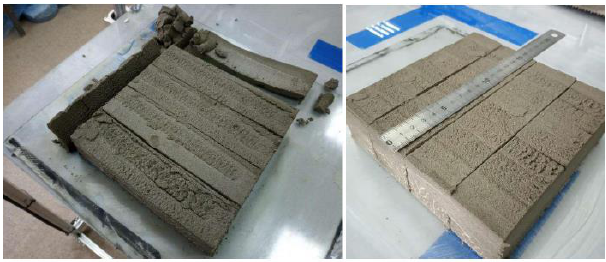
Figure 5. Newly formed specimens.